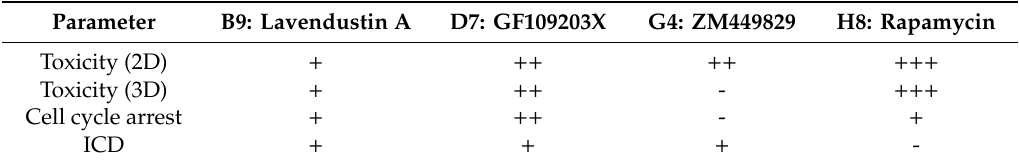
Table 2. Summary table of the key results identified in this study. Shown are the toxicity in 2D and 3D cultures with the combination treatment of the four in 2D cultures identified drugs, as well as cell cycle arrest and immunogenic cancer cell death-associated expression of cell surface markers. E ff ect intensity was graded ( +++ = high, ++ = intermediate, + = modest, - = no e ff ect). Parameter B9: Lavendustin A D7: GF109203X G4: ZM449829 H8: